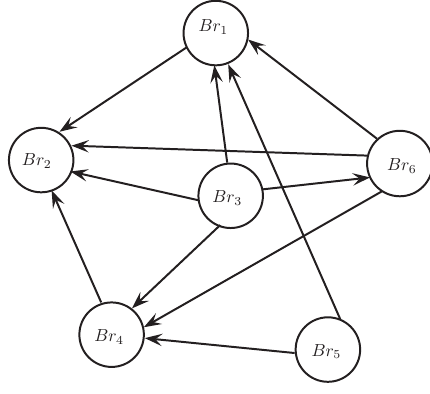
Figure 1. Graphical representation of outranking relation of bricks. Table 7. Tabular representation of comparison of